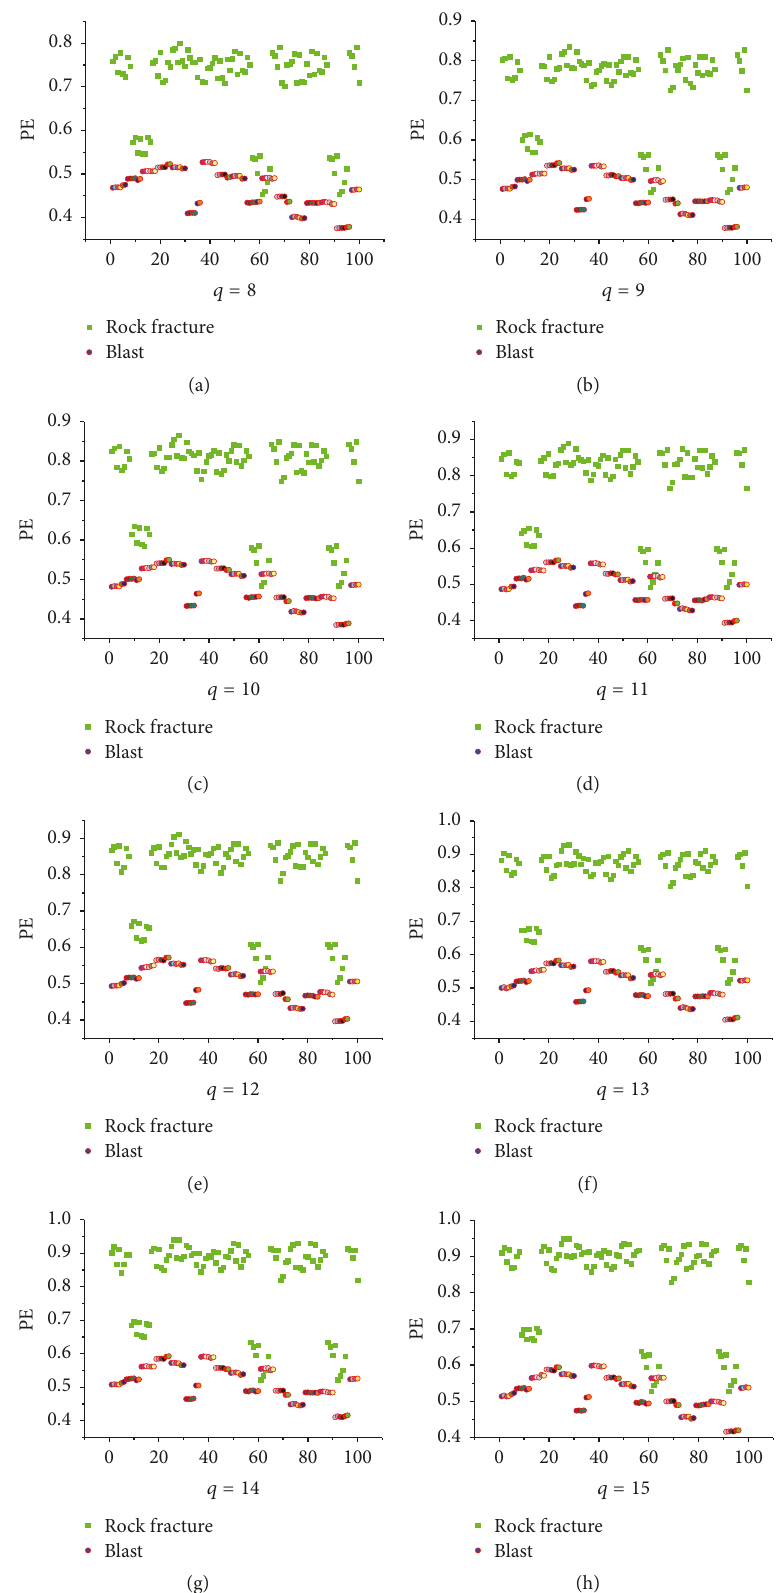
Figure 4: Permutation entropy of data with different scale factors. Permutation entropy with (a) 𝑞 = 8 , (b) 𝑞 = 9 , (c) 𝑞 = 10 , (d) 𝑞 = 11 , (e) 𝑞 = 12 , (f) 𝑞 = 13 , (g) 𝑞 = 14 , and (h) 𝑞 = 15